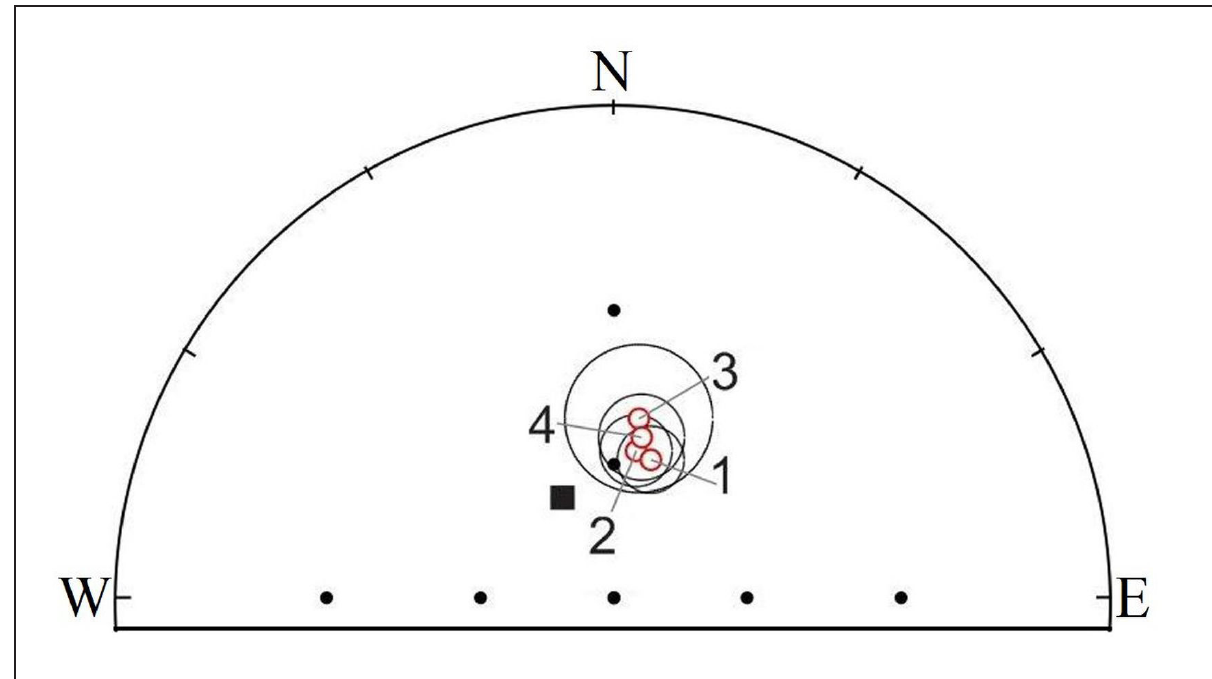
Figure 7: Site mean magnetisation directions for (1) KR1, (2) KR1 #6–31, (3) KR2 and (4) KR2 #14–30. The International Geomagnetic Reference Field direction is indicated by the square.